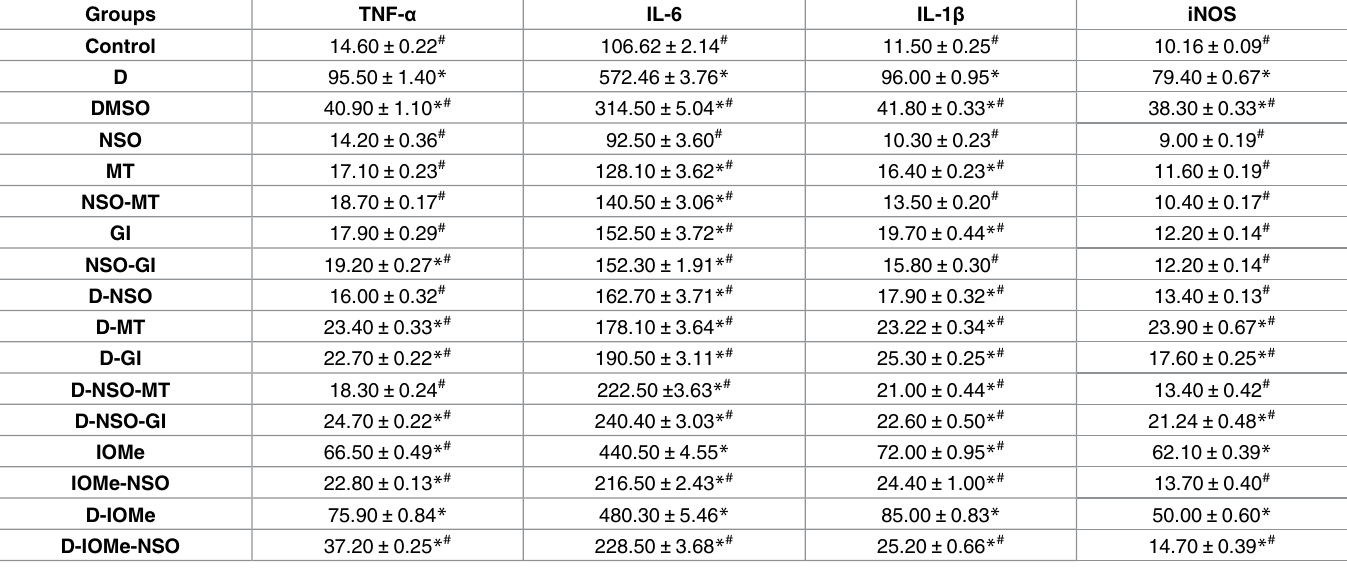
Table 5. Neuro-inflammation cytokines levels (pg/mg protein) in the brain of diabetic rats after treatment with NSO, antidiabetic drugs, combina- tion therapy and I-OMeAG538. Groups